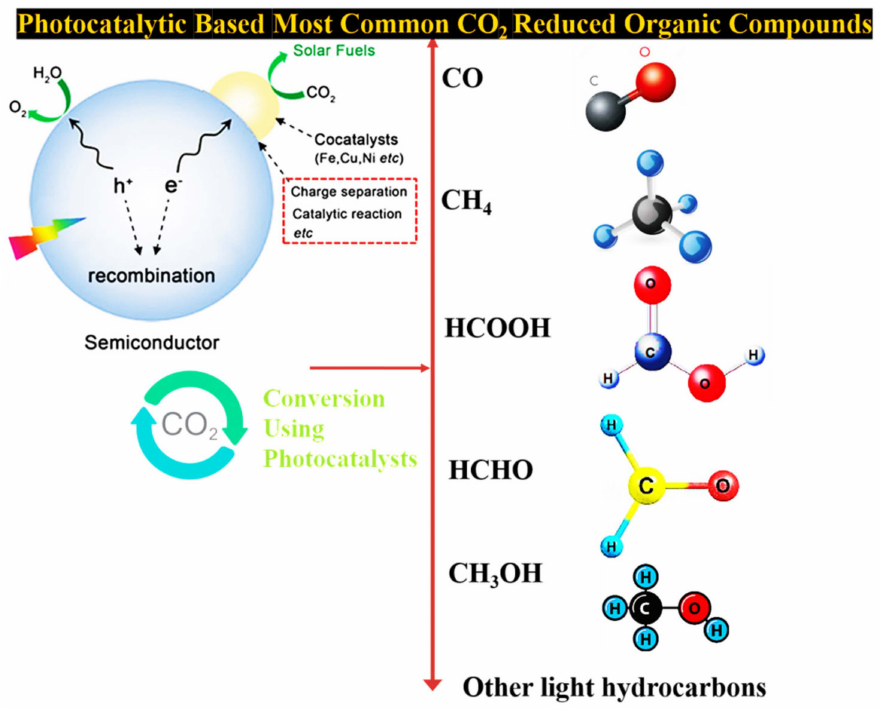
Figure 7. Mechanism of photocatalytic reduction of CO 2 and the most common reduced organic compounds produced in this